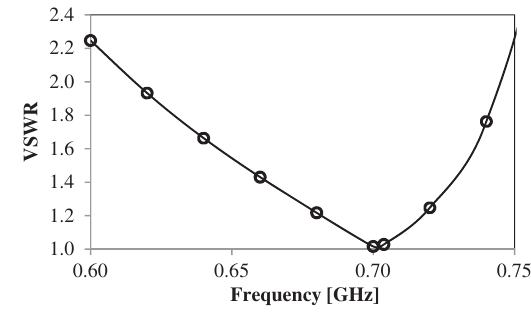
FIG. 7. Calculated VSWR of the doorknob.